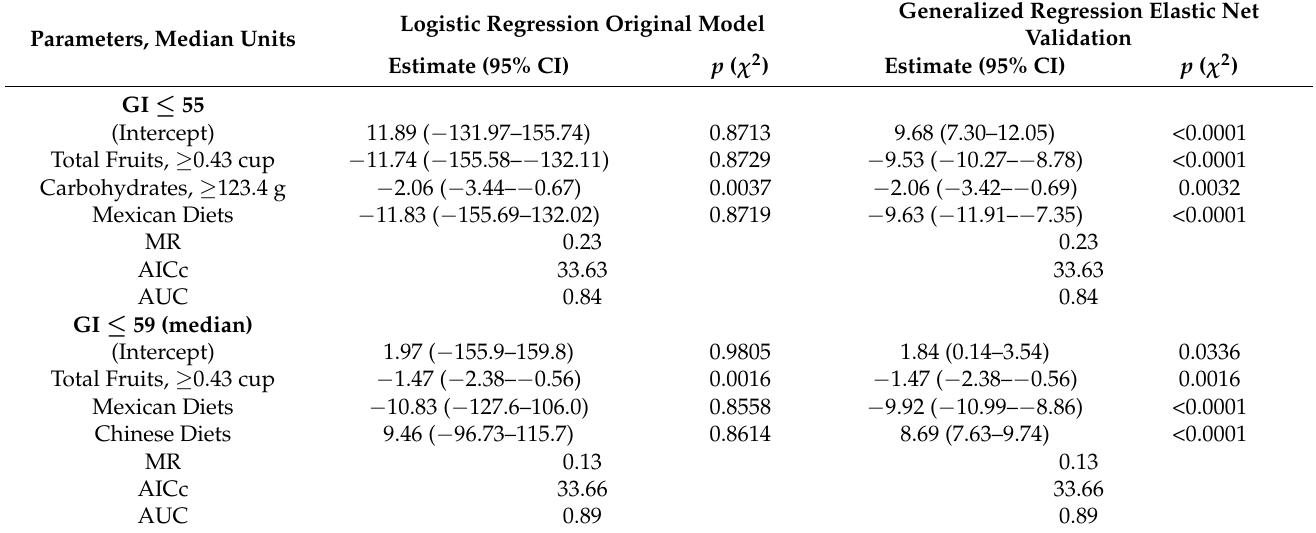
Table 3. Predictors of Glycemic